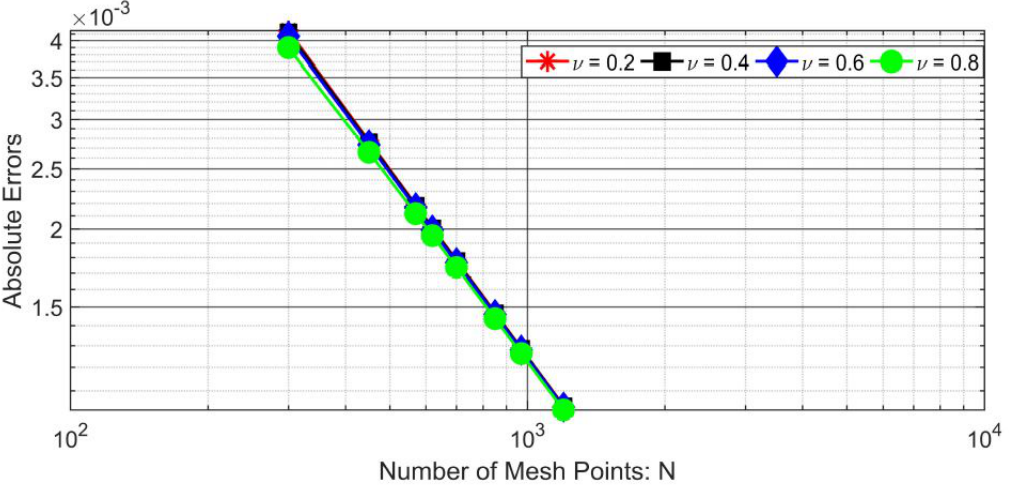
Figure 3. Logarithmic plot of absolute errors vs. number of mesh points for Problem